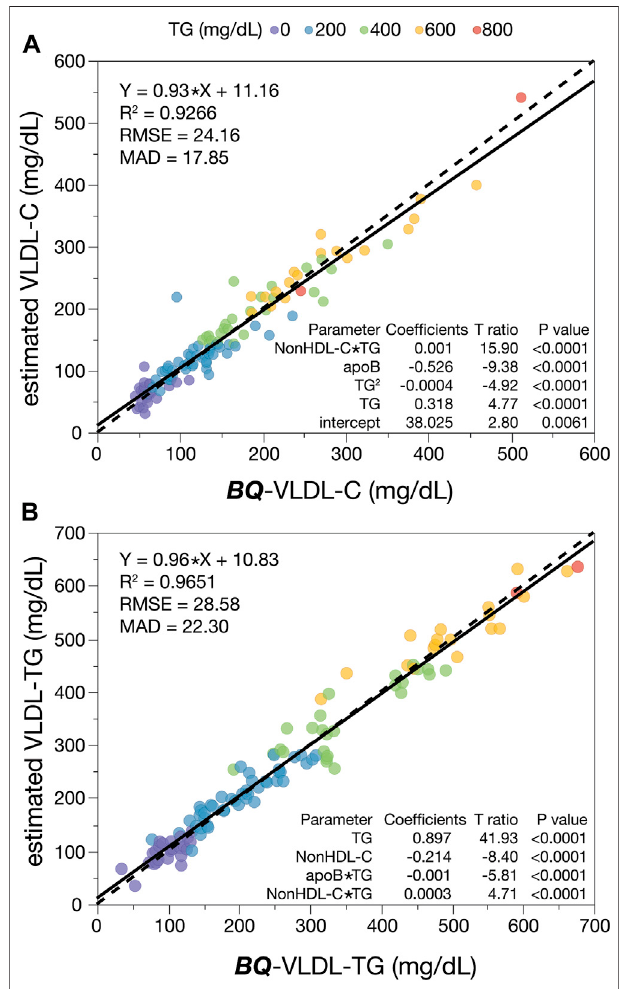
FIGURE 6 | HLP3 speci fi c equations for VLDL-C and VLDL-TG. HLP3 patients (N = 115) were used to develop a regression analysis for VLDL-C (A) and VLDL-TG (B) with the indicated input variables that include apoB. Solid lines are the linear fi t for the indicated regression equation. Dashed lines are the line of identity. Results are color-coded by TG levels with the value in the legend indicating the start of each interval.